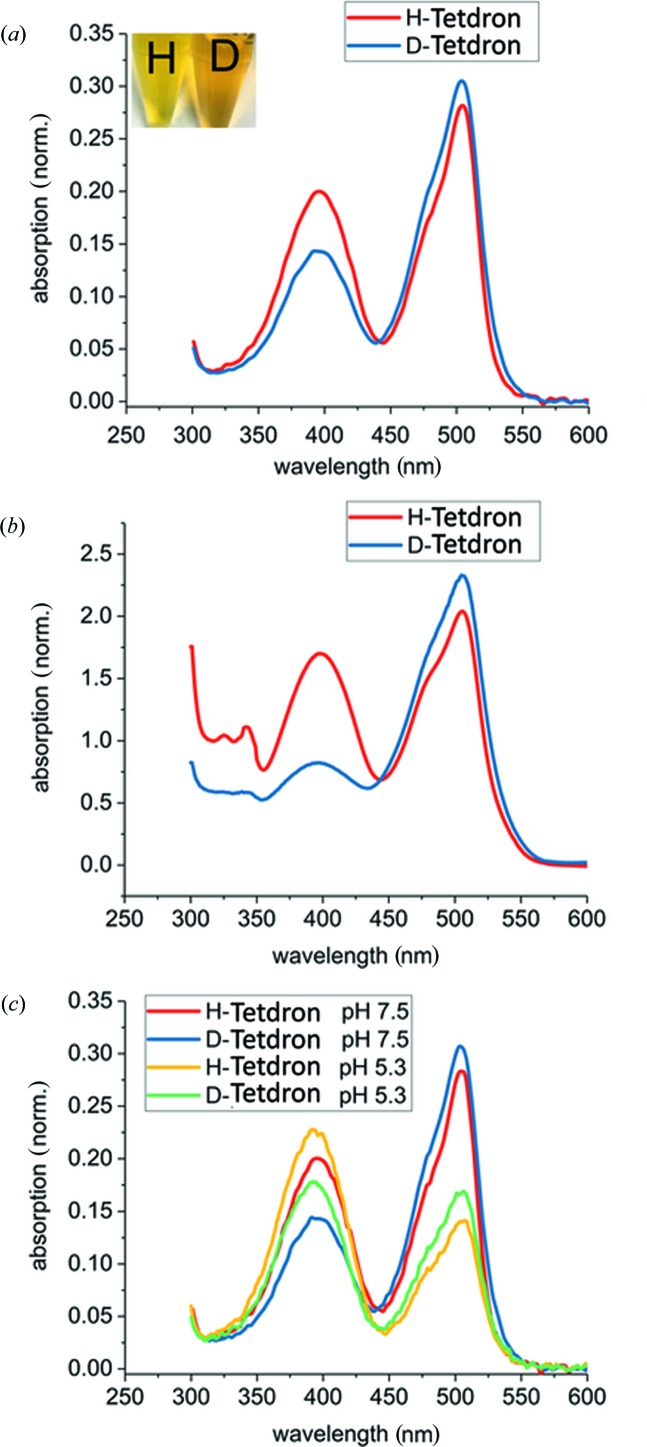
UV–vis spectra of hydrogenated and deuterated Tetdron in (a) solution and in (b) the crystal. (c) Comparison of solution UV–vis spectra at neutral and low pHs.